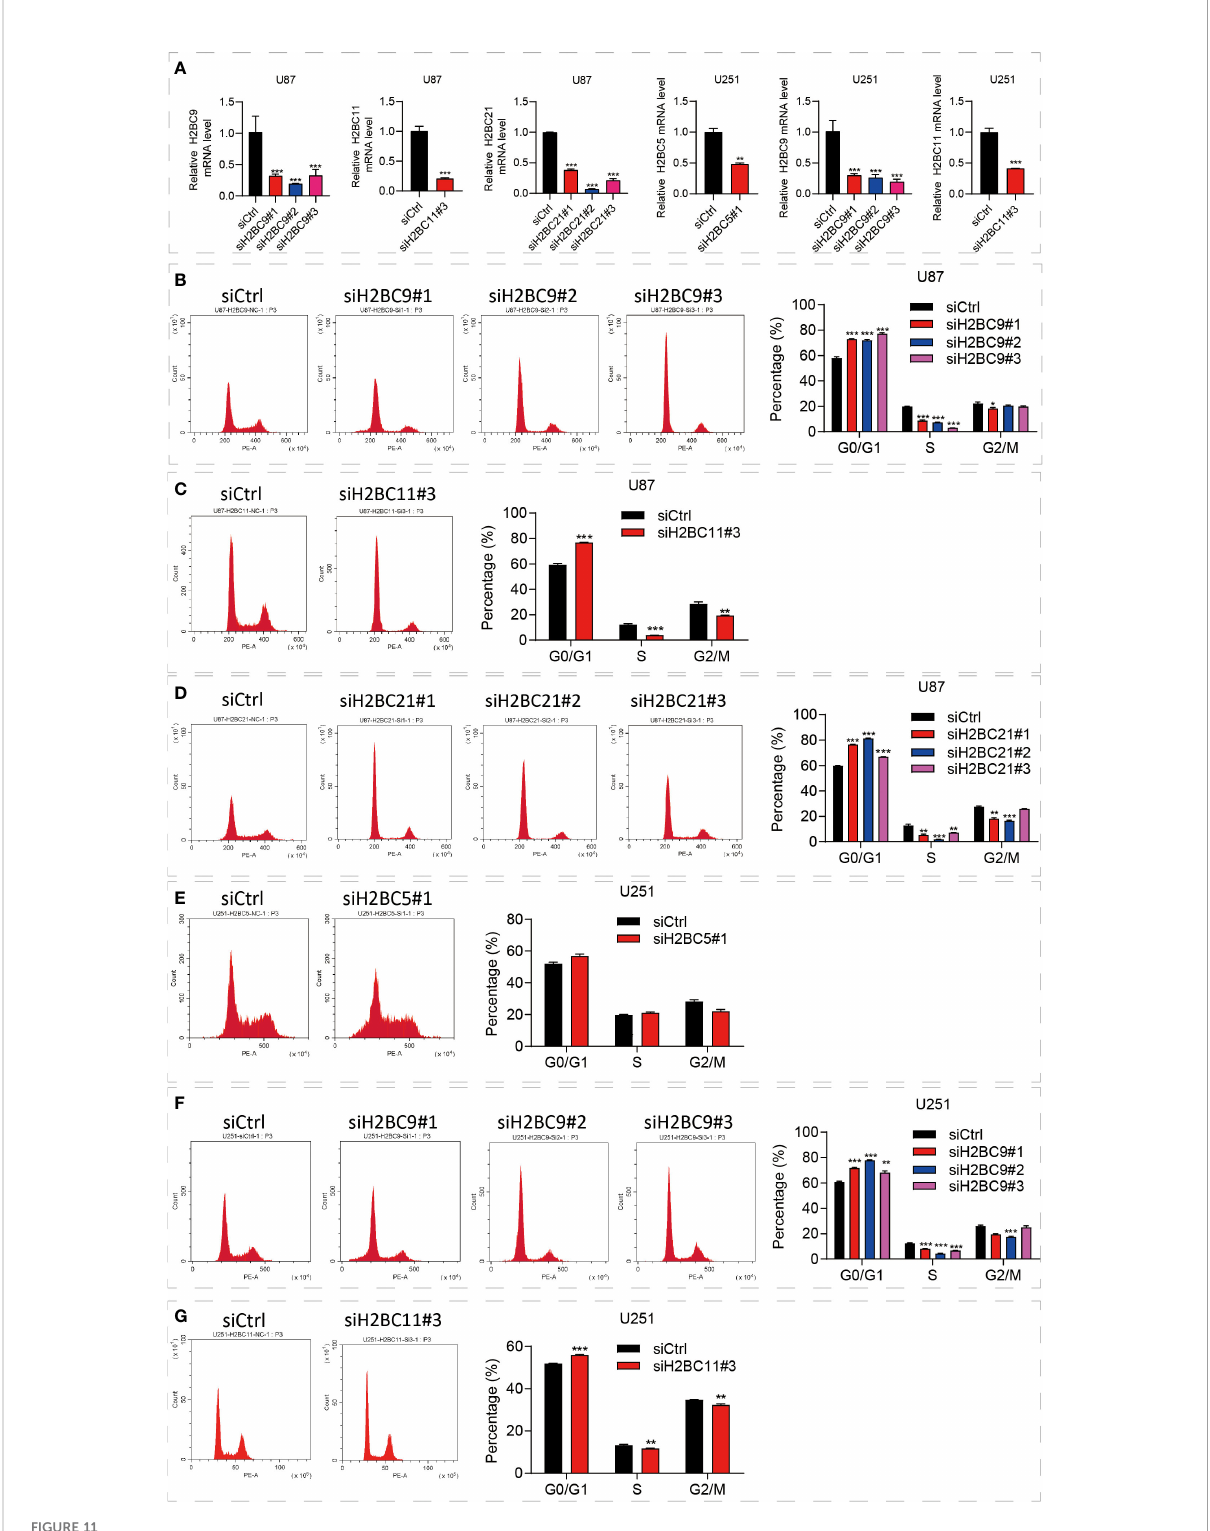
FIGURE 11 Knockdown of the H2B gene signi fi cantly affected the cell cycle. (A) Downregulated H2BC5, H2BC9, H2BC11 and H2BC21 expression levels upon transfection each siH2Bs in U87 MG and U153 cell lines separately. (B – G) Flow cytometry was used to detect the cell cycle distribution of U87 and U251 cell lines. **P < 0.01, ***P <